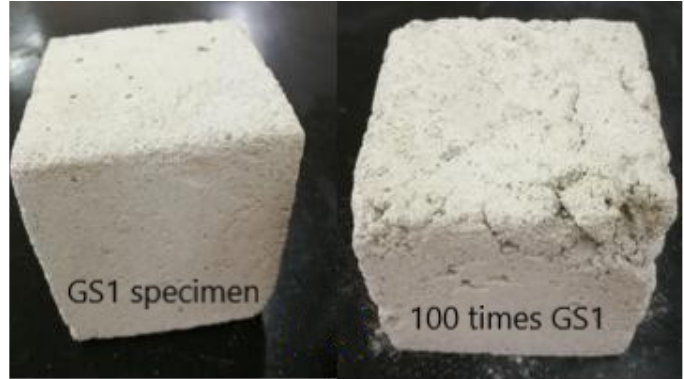
Figure 10. GA5 geopolymer and after 100 times test GA5 geopolymer.